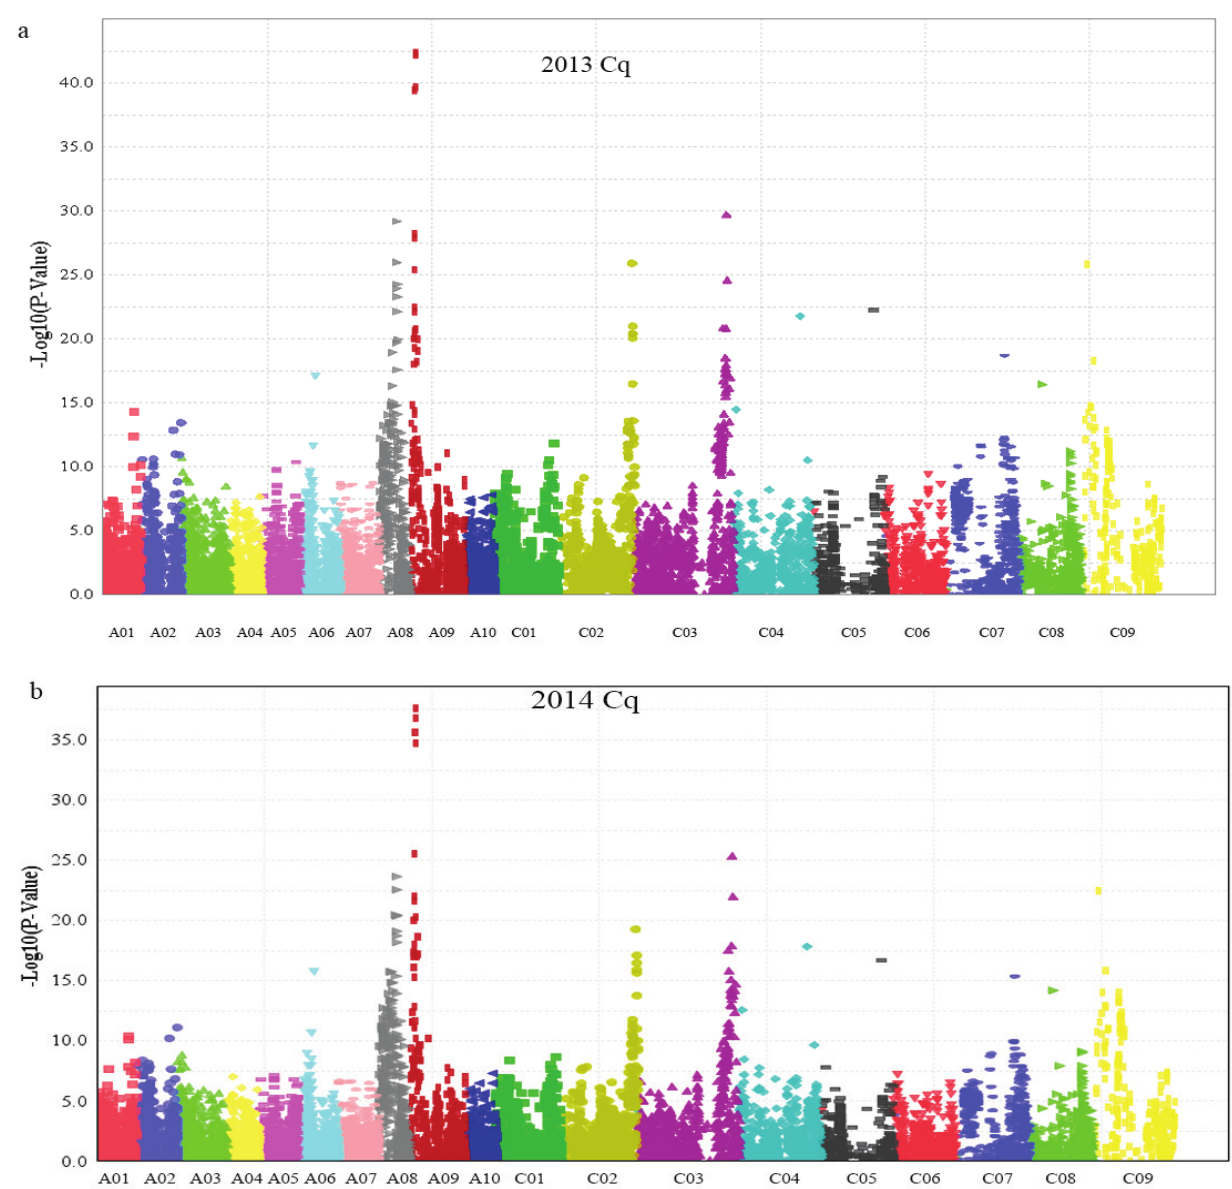
Figure 5. Manhattan plot describing marker-trait associations for the total seed glucosinolate content of the population (consisting of 520 accessions) in 2013 and 2014. ( a ) Manhattan plot describing marker-trait associations for the total seed glucosinolate content in 2013; ( b ) Manhattan plot describing marker-trait associations for the total seed glucosinolate content in 2014. Cq refers to the growing region, Chongqing,